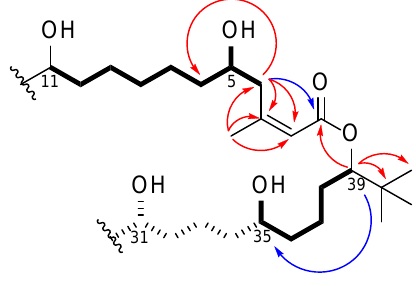
Figure 2. Key correlations deduced from COSY/TOCSY (bolded bonds), HMBC data (red arrows), and LR-HSQMBC data (blue arrows) leading to the partial structure of palstimolide A ( 1 ). The dashed bond section was assembled from 1D TOCSY data in MeOH- d 4 , which connected H35 with